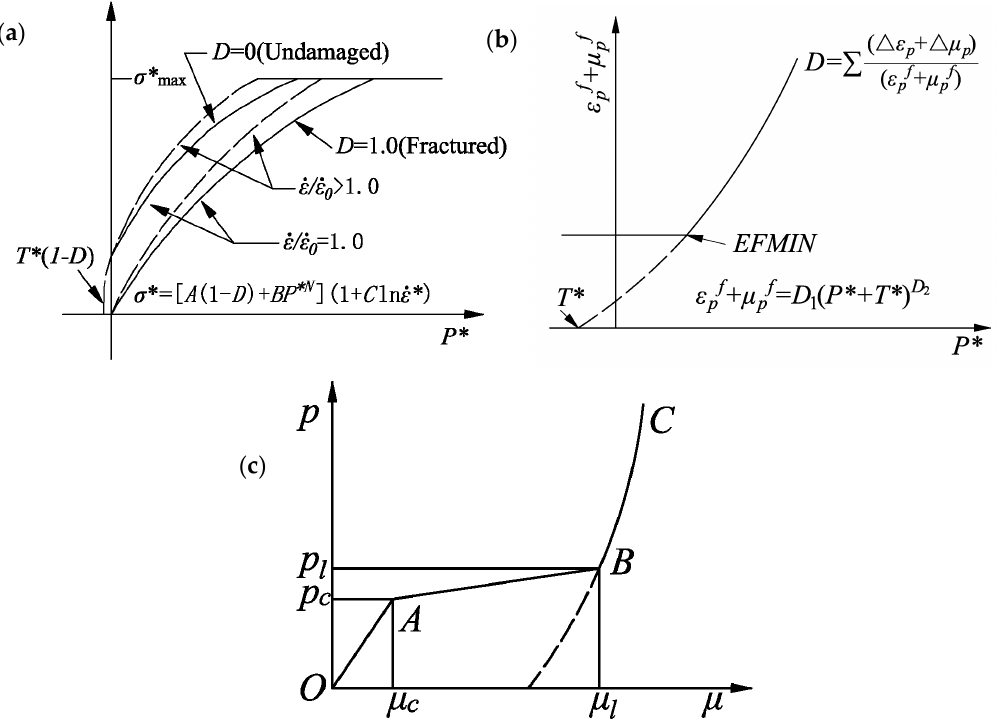
Figure4. OriginalHolmquist–Johnson–Cook(HJC)model. ( a )Equationoftheyieldsurface. ( b )Damage Figure 4. Original Holmquist–Johnson–Cook (HJC) model. ( a ) Equation of the yield surface. ( b ) model of concrete. ( c ) Hydrostatic pressure and volumetric strain curve of Damage model of concrete. ( c ) Hydrostatic pressure and volumetric strain curve of concrete.